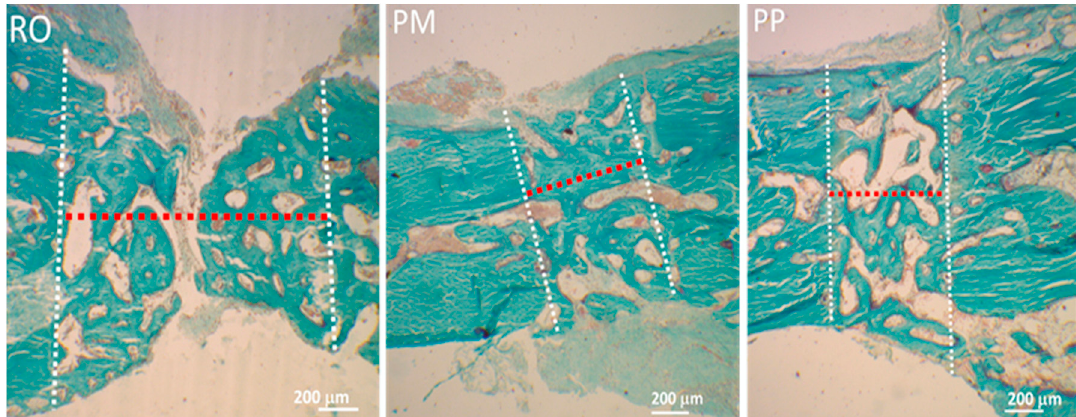
Figure 2. Light microscope (LM) micrographs showing the thickness (red dotted line) of the osteotomy (between the two white dotted lines) obtained using the three different devices (RO, PM, PP), producing different bone gaps. Note that the RO device produces a gap around twice the width of those produced by PM and PP. Perivascular stromal spaces among the bone-forming trabeculae appear wider in RO osteotomy.